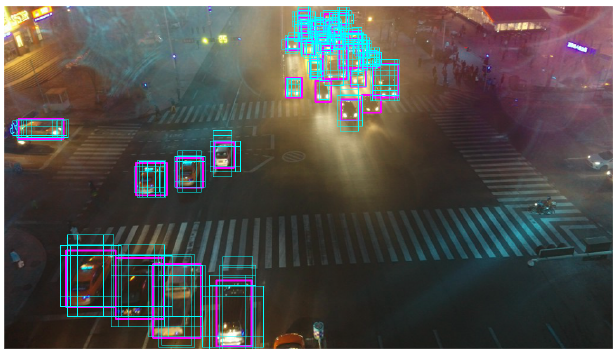
Figure 3. Sampling Results Example on Big Objects.